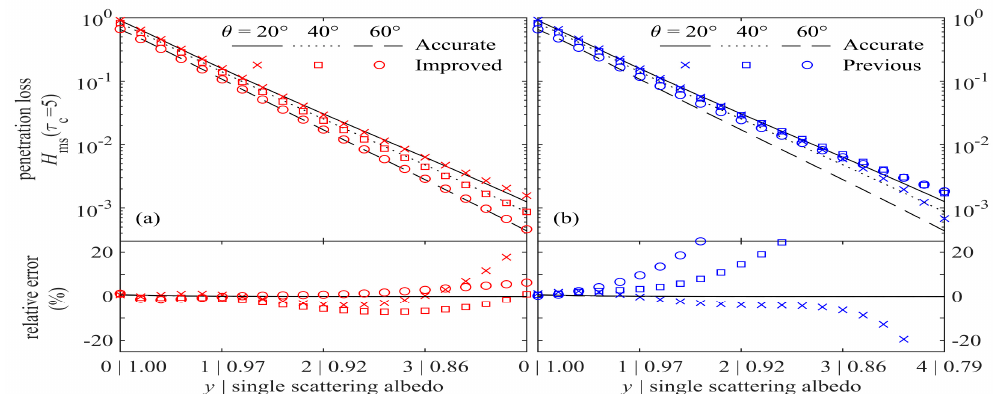
Figure 5. ( a ) The modified function H ms and the relative errors compared to the accurate value from DISORT. The accurate H ms is calculated as (cid:3435)𝑅(cid:3560) (cid:2998) − 𝑅 (cid:2998),(cid:2926)(cid:2918) (cid:3439) − (cid:3435)𝑅(cid:3560) − 𝑅 (cid:2926)(cid:2918) (cid:3439) . ( b ) The function H and the relative errors were calculated based on the previous study [32] . The accurate H is calculated as 𝑅(cid:3560) (cid:2998) −